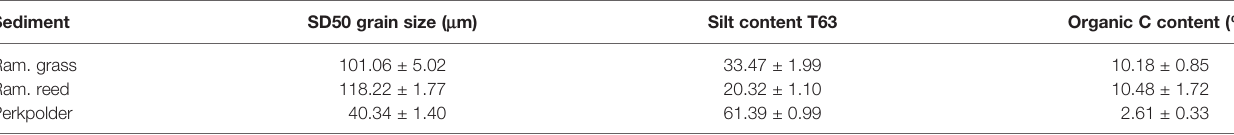
TABLE 1 | Properties of sediment collected from different